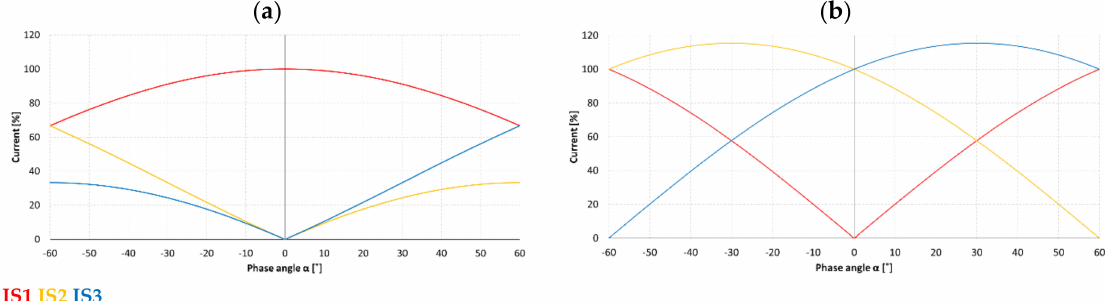
Figure 10. PST “S” side short circuit current contribution for ( a ) phase-to-ground and ( b ) phase-to-phase fault on “L”